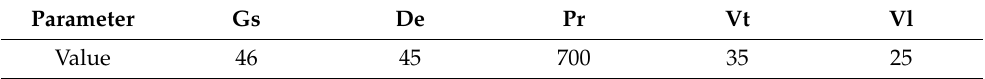
Table 4. Results of the multi-objective optimization in the semi-finish honing operation.